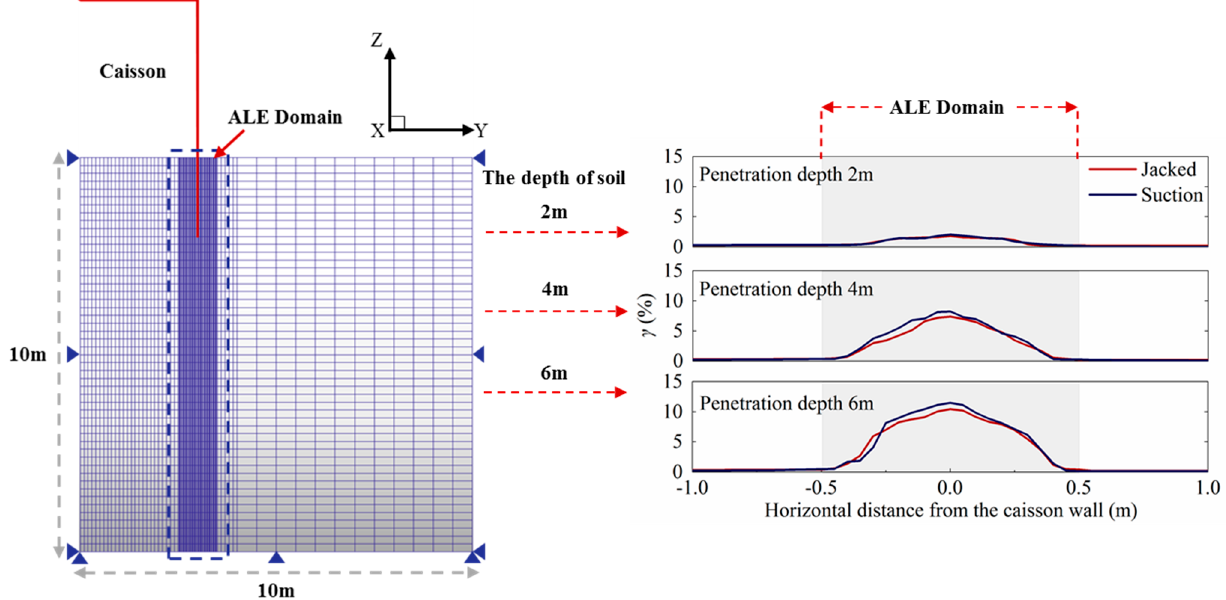
Figure 3. Numerical model for suction caisson installation analysis along with the shear strain distribution within soil near the caisson wall during a typical jacked penetration process.